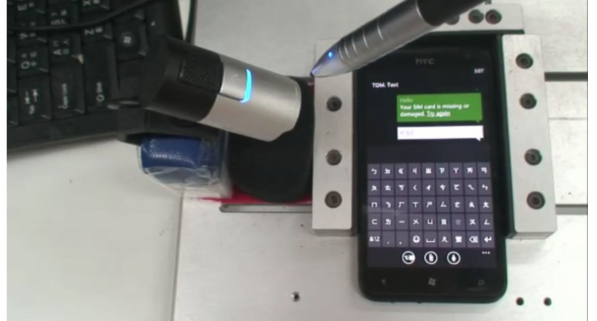
Figure 19. Before moving the camera.